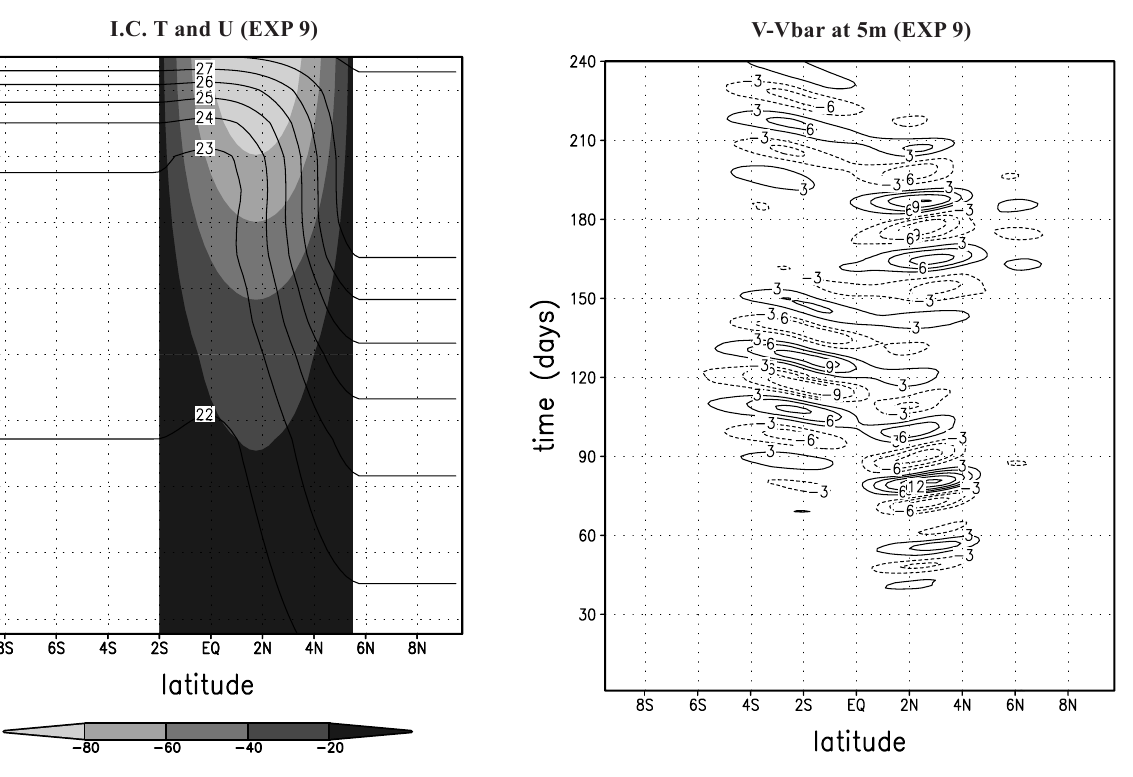
Fig. 6. Depth-latitude section of zonally uniform horizontal velocity (shaded) and temperature field (contour) used as the initial condition for EXP 9. Contour intervals are 1 ◦ C for temperature and 20cm/s for velocity.